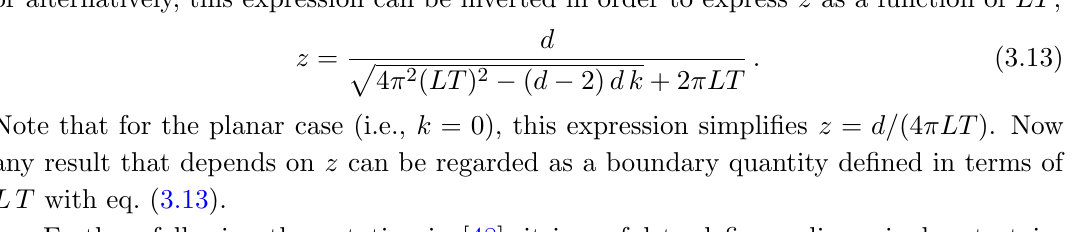
JHEP06(2018)046